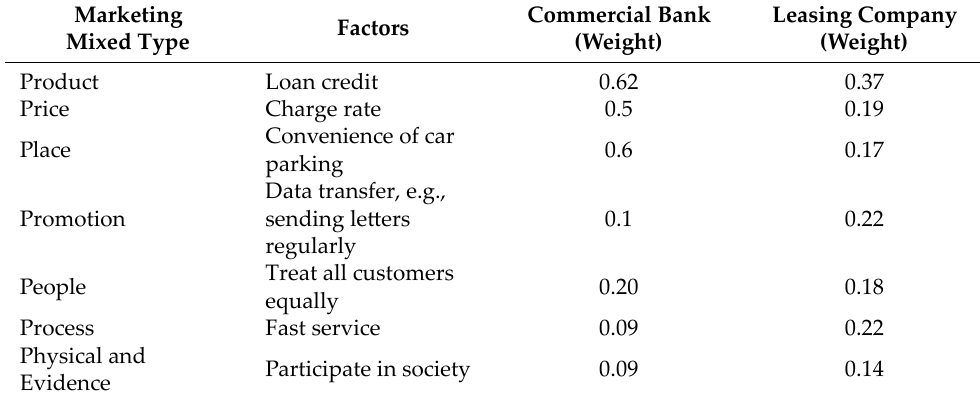
Table 4. Factor suggestion for adjusting leasing company’s